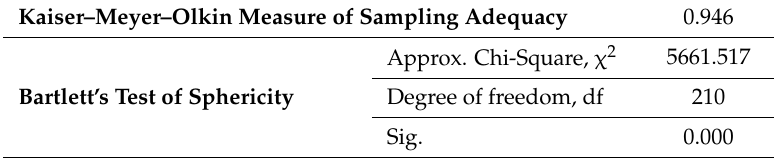
Table 2. Kaiser–Meyer–Olkin (KMO) measure and Bartlett’s Test on the critical success factors (CSFs). Kaiser–Meyer–Olkin Measure of Sampling